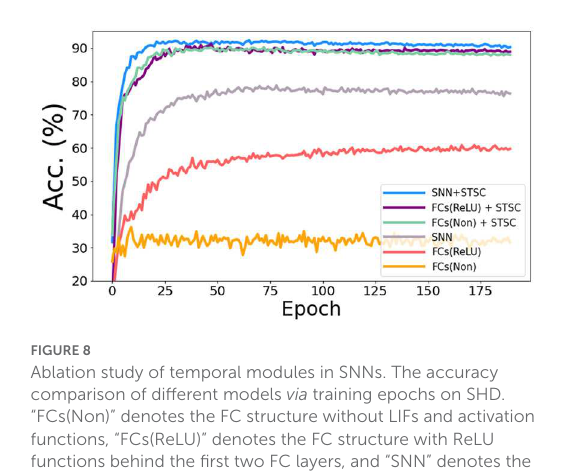
FIGURE8 Ablation study of temporal modules in SNNs. The accuracy comparison of different models via training epochs on SHD. “FCs(Non)” denotes the FC structure without LIFs and activation functions, “FCs(ReLU)” denotes the FC structure with ReLU functions behind the first two FC layers, and “SNN” denotes the FC structure with LIFs behind all three FC layers. Then, STSC modules are added just behind input (P1) in three models as a